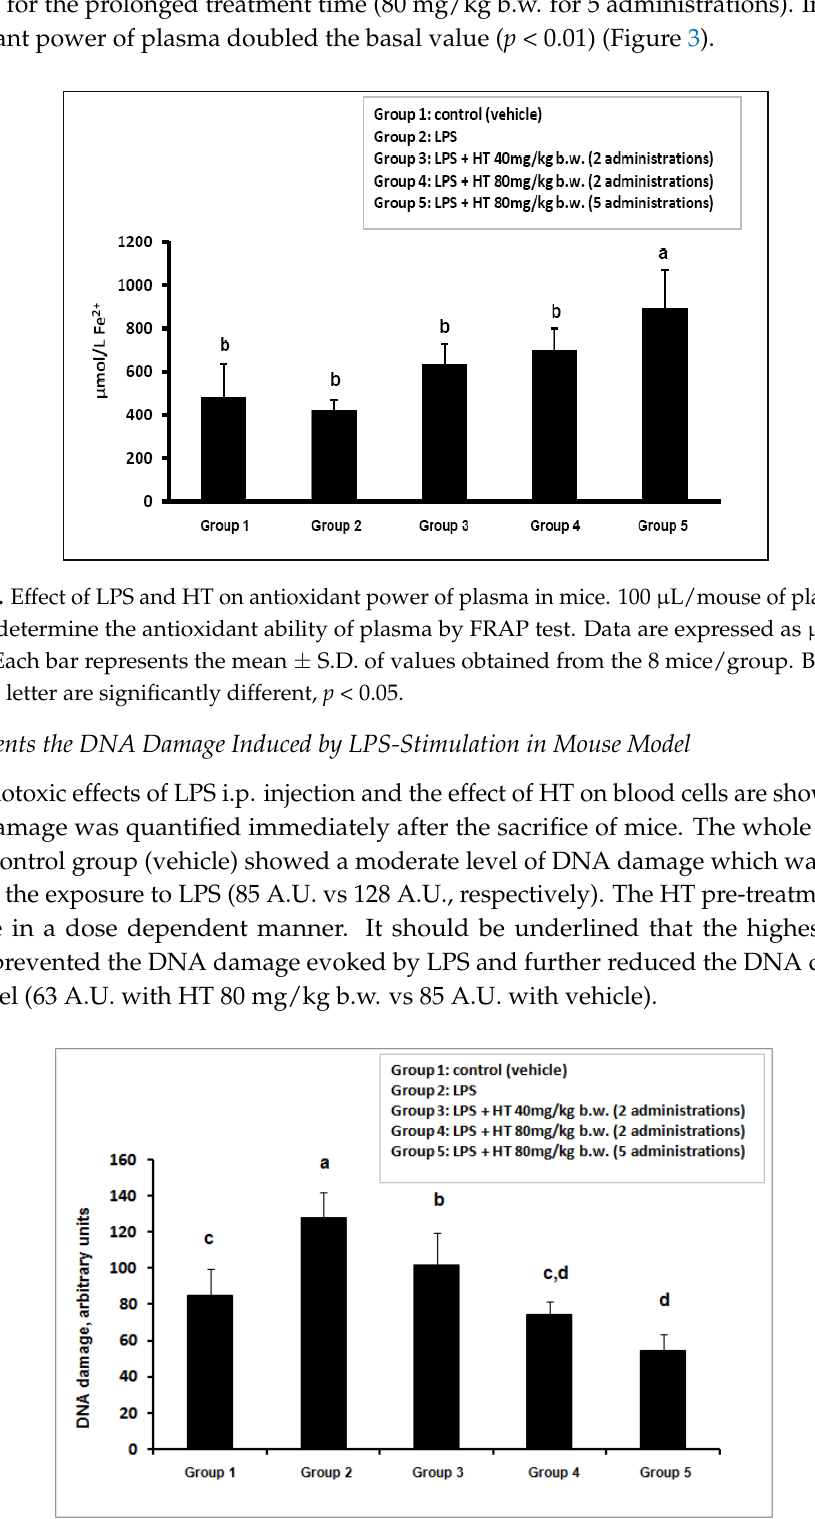
Figure 4. Effect of HT on DNA damage in whole blood cells.10 µL of cell suspension were included in 75 µL of low melting point agar and used for the comet assay. Data are expressed as arbitrary units as described in Materials and Methods Section. Each bar represents the mean ± S.D. of values obtained from the 8 mice/group. Bars with a different letter are significantly different, p < 0.05.